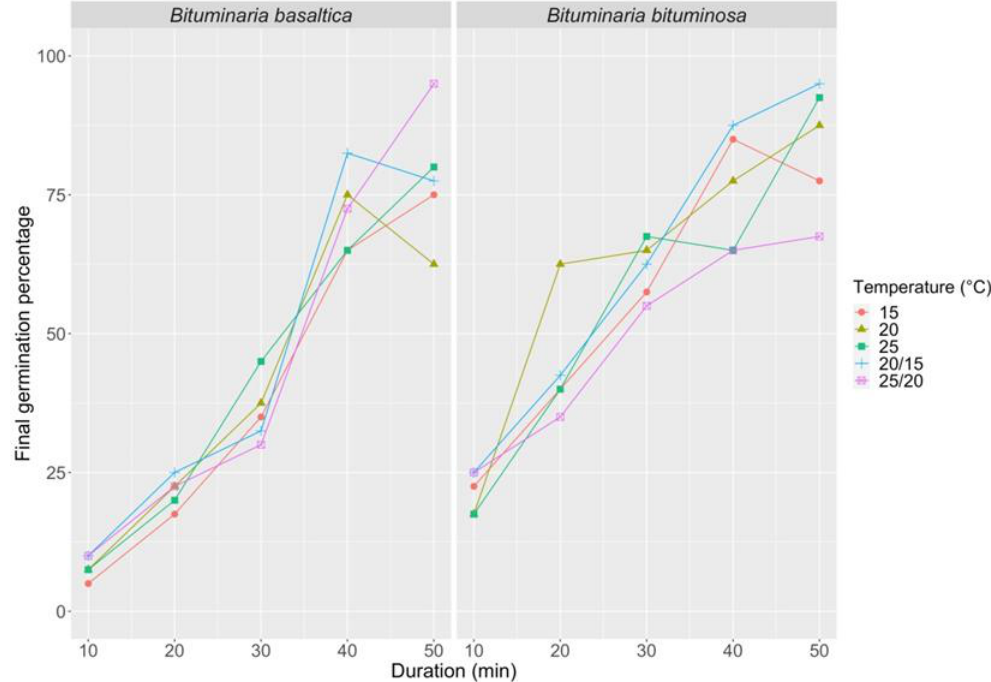
Figure 3. Final germination percentage at di ff erent incubation temperatures (15, 20, 25, 20 / 15, 25 / 20 ◦ C, 12 / 12 h photoperiod and thermoperiod) in B. basaltica and B. bituminosa, after di ff erent immersion times (10, 20, 30, 40, 50 min treatment duration) in H 2 SO 4 .